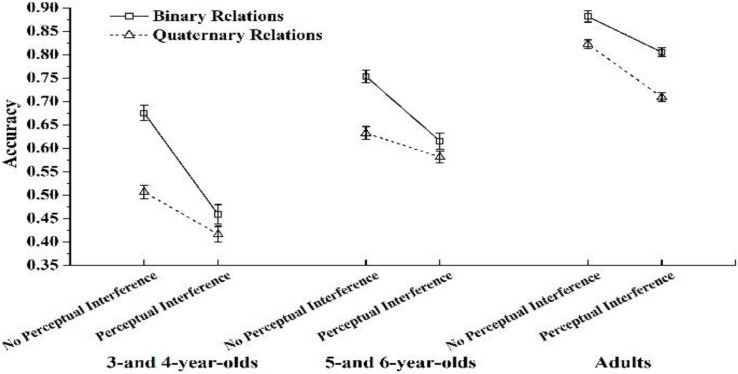
Accuracies as a function of relational integration and perceptual interference across age groups.